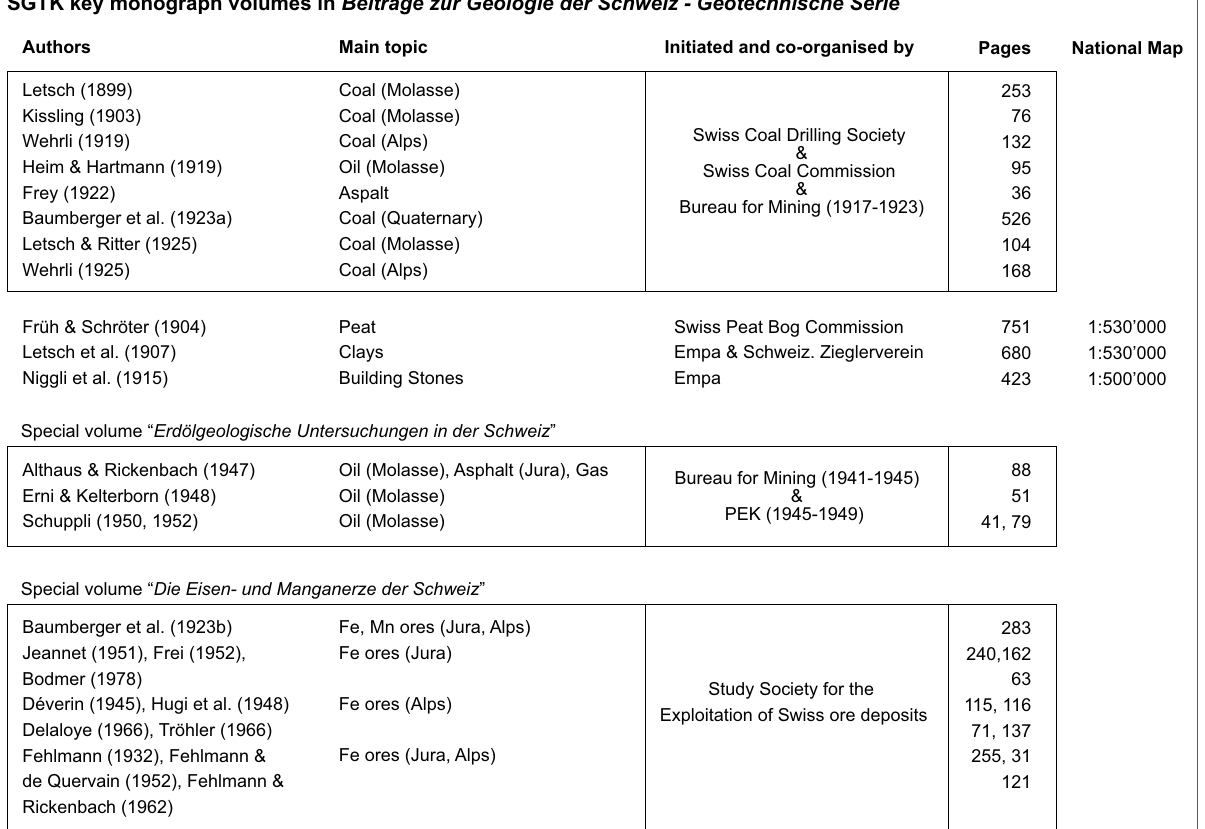
Fig. 5 Overview of the most significant SGTK monographs that were published in the Geotechnical Series ( Beiträge zur Geologie der Schweiz— Geotechnische Serie). The first box lists the 8 volumes on hydrocarbons that were initiated before or in the earliest years of SGTK. The three volumes below are also very early (1904–1915) works and of great volume. They all include a nation-wide occurrences map and extensive, systematic statistics of the various material tests on samples from all the documented occurrences. The second and third box list the monographs of the two special volumes documenting the then main SGTK research focus on oil (1940 to early 1950s) and on iron ores (ca. 1950–1960s). The SGTK monographs Beiträge zur Geologie der Schweiz can be downloaded here: https:// shop. swiss topo. admin. ch/ de/ produ cts/ publi catio ns/ geolo gy/